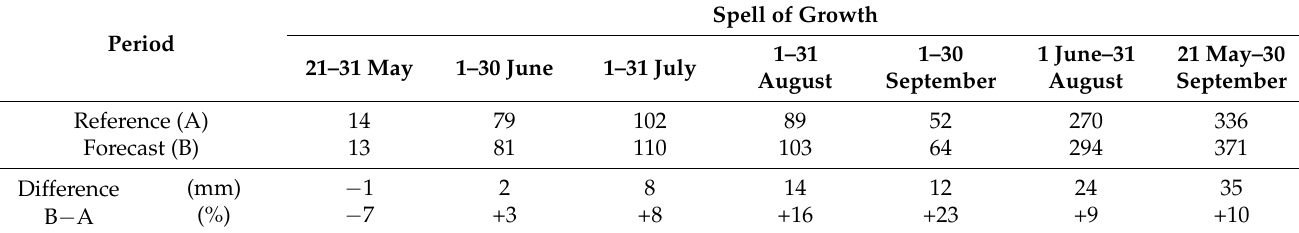
Table 5. Water needs (mm) of giant miscanthus during its specific spells of growth in the reference (1981–2010) and forecast (2021–2050)